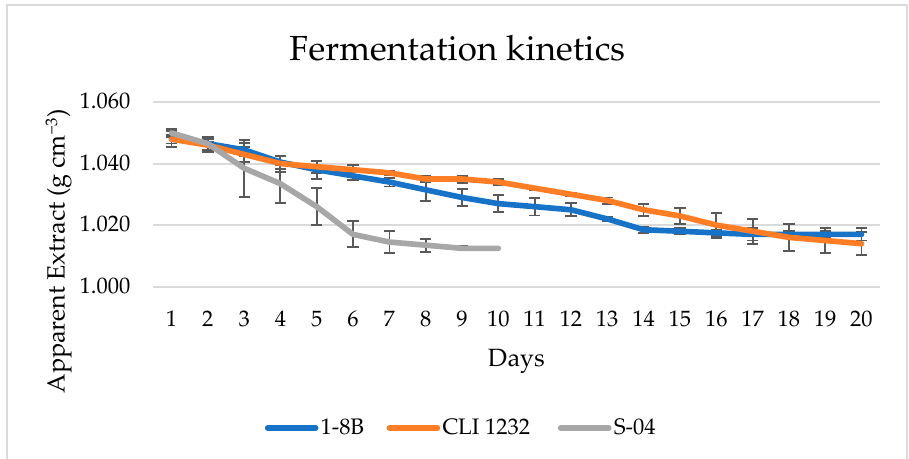
Figure 5. Fermentation kinetics of the L. thermotolerans strains fermented in 100 L and S-04 control strain.